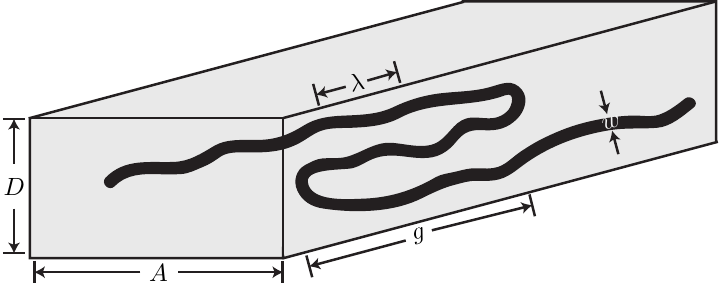
Figure 1. Schematic illustration of a wormlike chain confined in a rectangular nanochannel of depth D and width A > D . The global persistence length g is the typical distance between hairpin bends, while the deflection segment length λ arises from the deflections off the channel walls. The excluded volume is given by a hardcore interaction with width w equal to the diameter of the chain. The global persistence length and deflection segment length are not drawn to